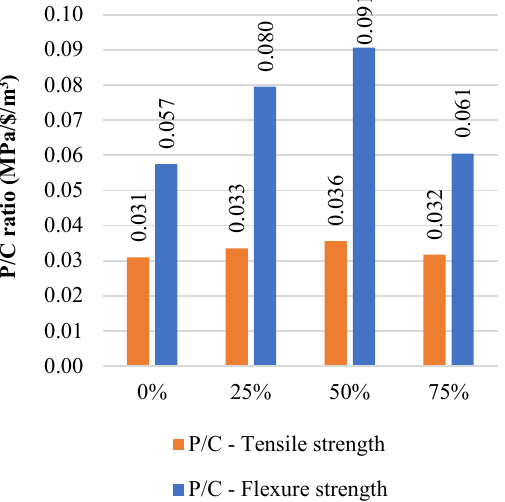
Figure 17. P/C ratios for split tensile and flexure strengths. Table 4. Cost analysis details for each concrete mix.